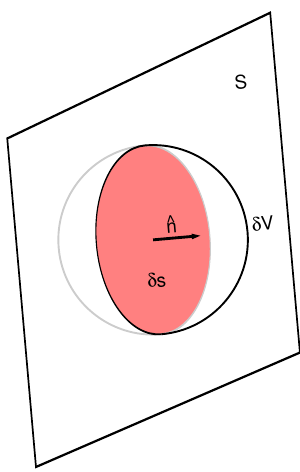
Figure 1. The intersection of the blade surface with a small volume of